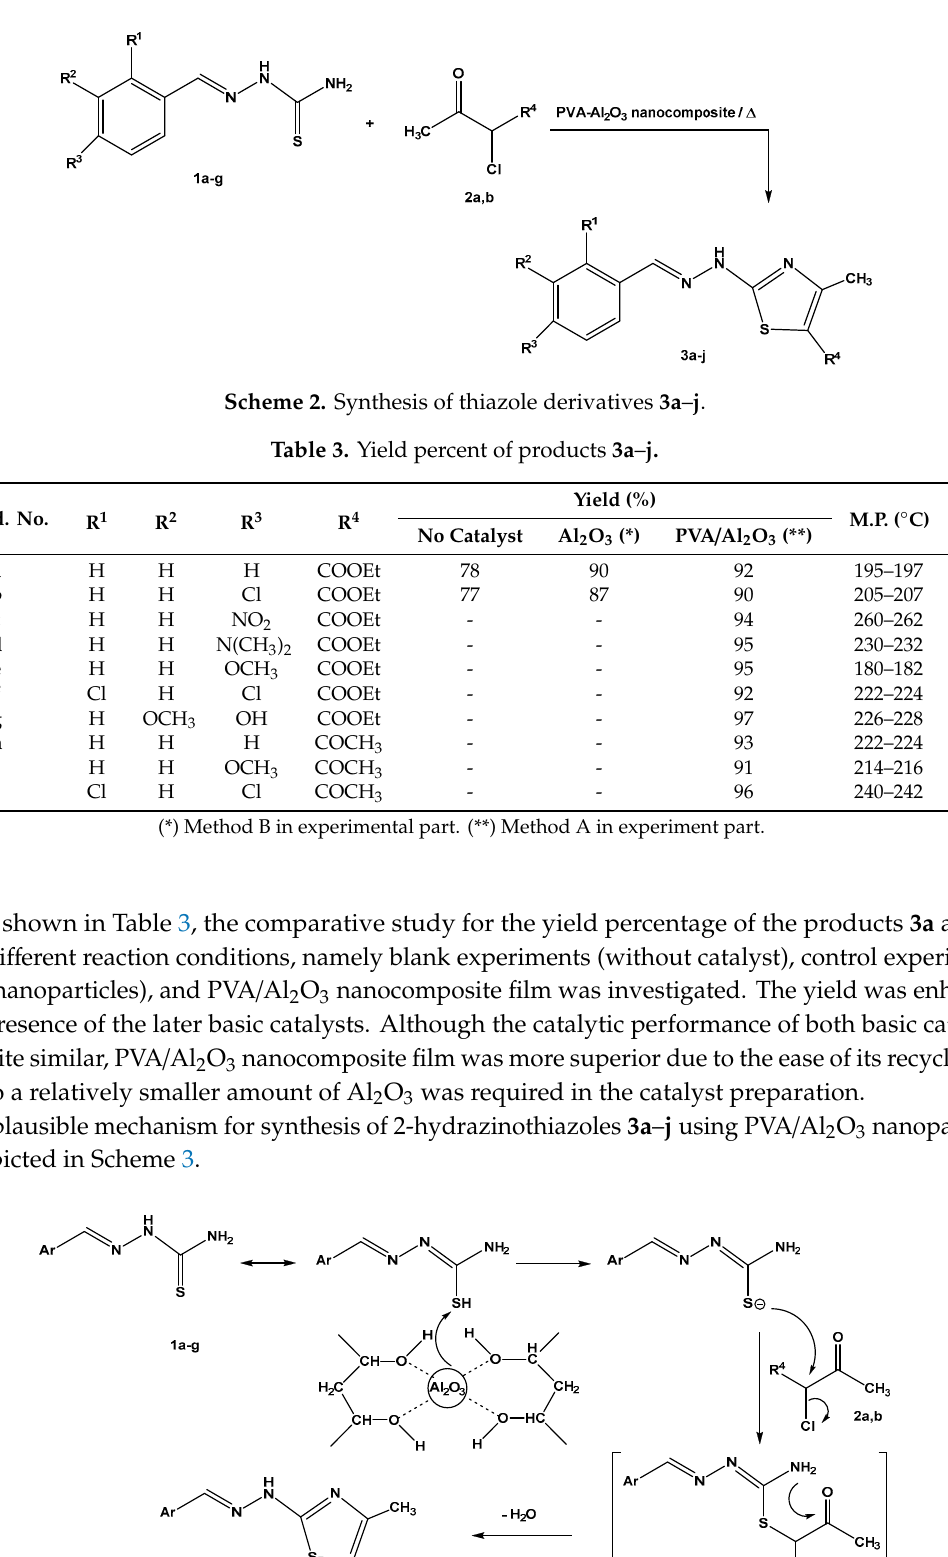
Figure 6. Images of virgin PVA and PVA-Al 2 O 3 nanocomposite.